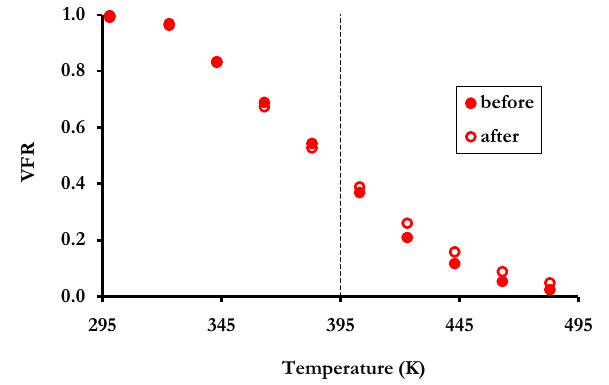
Fig. 2. The temperature dependence for the VFR, i.e. thermo- grams, before and after limonene SOA ageing in AIDA experiment SOA08-12. The dashed line indicates 395K.